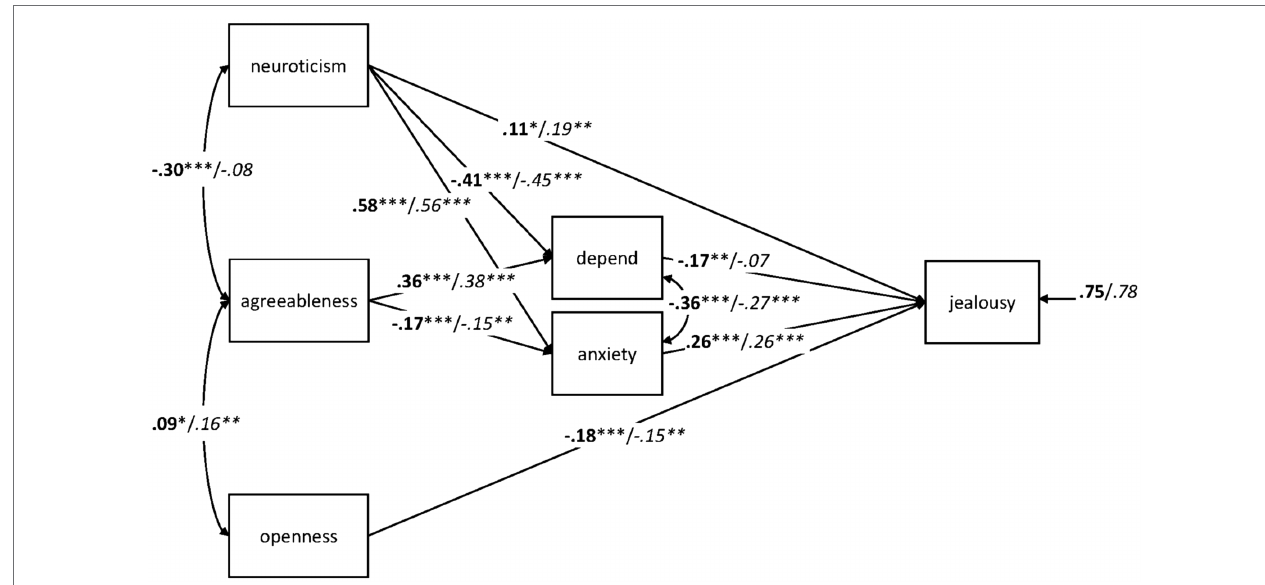
FIGURE 2 | Path analysis with standardized estimates for the relationships between the adult attachment subscales depend and anxiety , neuroticism, agreeableness, openness, and jealousy in 338 men (italics) and the 509 women (bold). * p < 0.05; ** p < 0.01; *** p < 0.001.